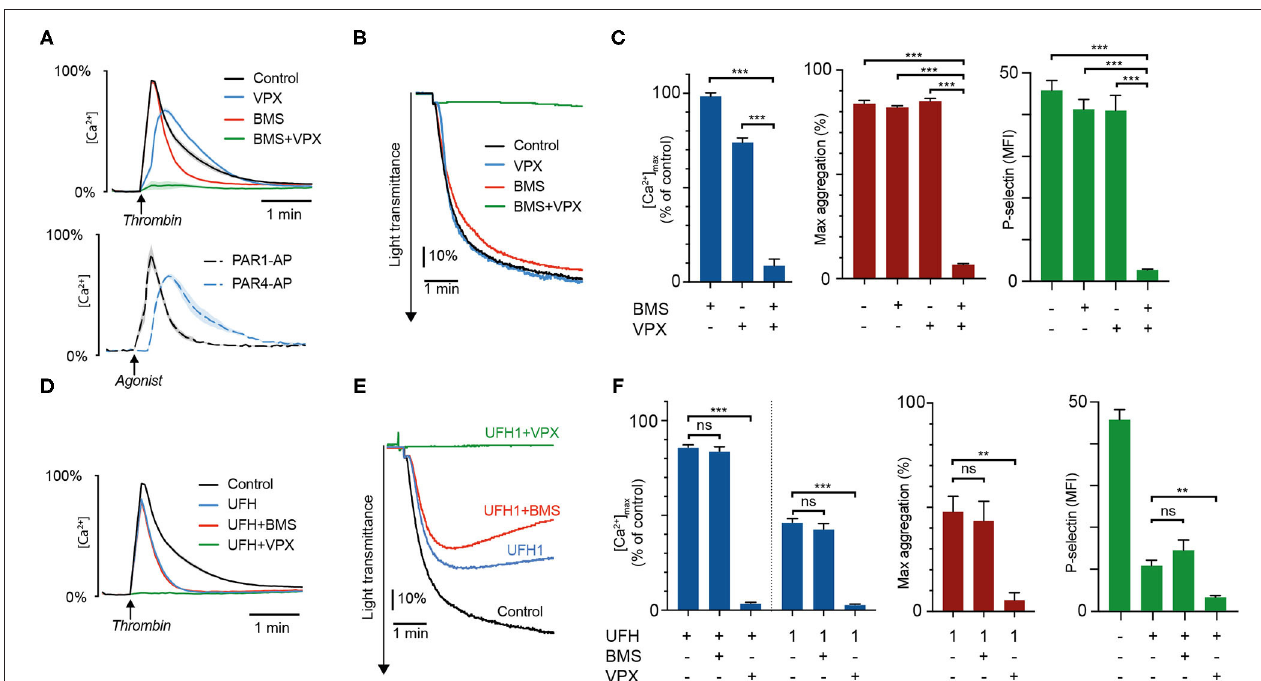
FIGURE 1 | Heparin preferentially inhibits thrombin-induced platelet activation via PAR4. Intracellular calcium mobilization, platelet aggregation, and P-selectin exposure was measured in suspensions of washed platelets supplemented with 1 U/mL antithrombin after addition of the PAR1-inhibitor vorapaxar (5 µ mol/L), the PAR4-inhibitor BMS-986120 (100 nmol/L), or heparin (0.2 U/mL, unless specified as 1 U/mL). Platelets were activated with 4 U/mL α -thrombin. (A–C) show the inhibitory effects of PAR-inhibitors alone and in combination. Calcium profiles generated with PAR1-AP (15 µ M) and PAR4-AP (150 µ M) are presented for comparison. (D–F) show the effects of heparin ± PAR inhibitors. Results represent the mean ± SEM (Calcium measurements: Control, VPX, n = 12; BMS, BMS + VPX, n = 8; UFH, n = 11; UFH + BMS, n = 7; UFH + VPX, n = 6; PAR1- and PAR4-AP, n = 3. LTA: In (C) Control, n = 10; BMS, n = 6; VPX, n = 9; BMS + VPX, n = 5. In (F) UFH, n = 8; UFH + BMS, UFH + VPX, n = 4. Flow cytometry: Control, n = 12; BMS, VPX, UFH, n = 10; BMS + VPX, n = 9; UFH + BMS, UFH + VPX, n = 4). (B,E) show representative data. ** P < 0.01; *** P < 0.001; not significant (ns). VPX, vorapaxar; BMS, BMS-986120; UFH, unfractionated